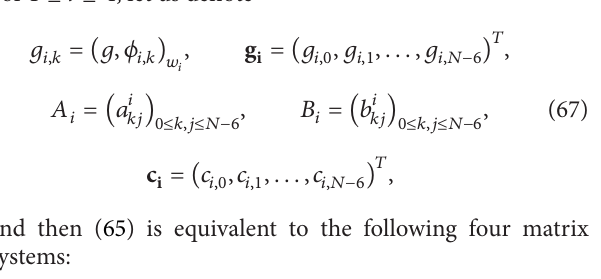
Table 1: Maximum absolute error 𝐸 for 𝑁 = 8 , 12 , 16 .